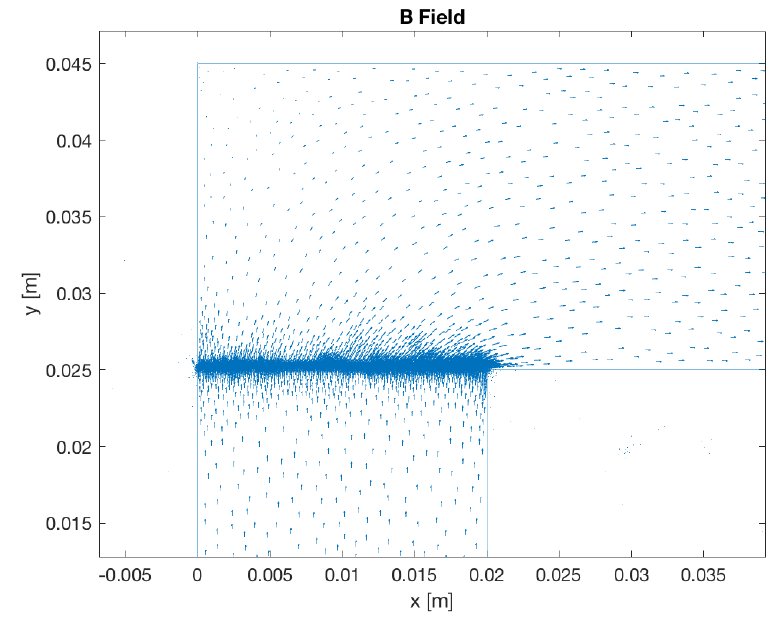
Figure 3. Magnetic induction field vector distribution computed by FEA in the air gap region.